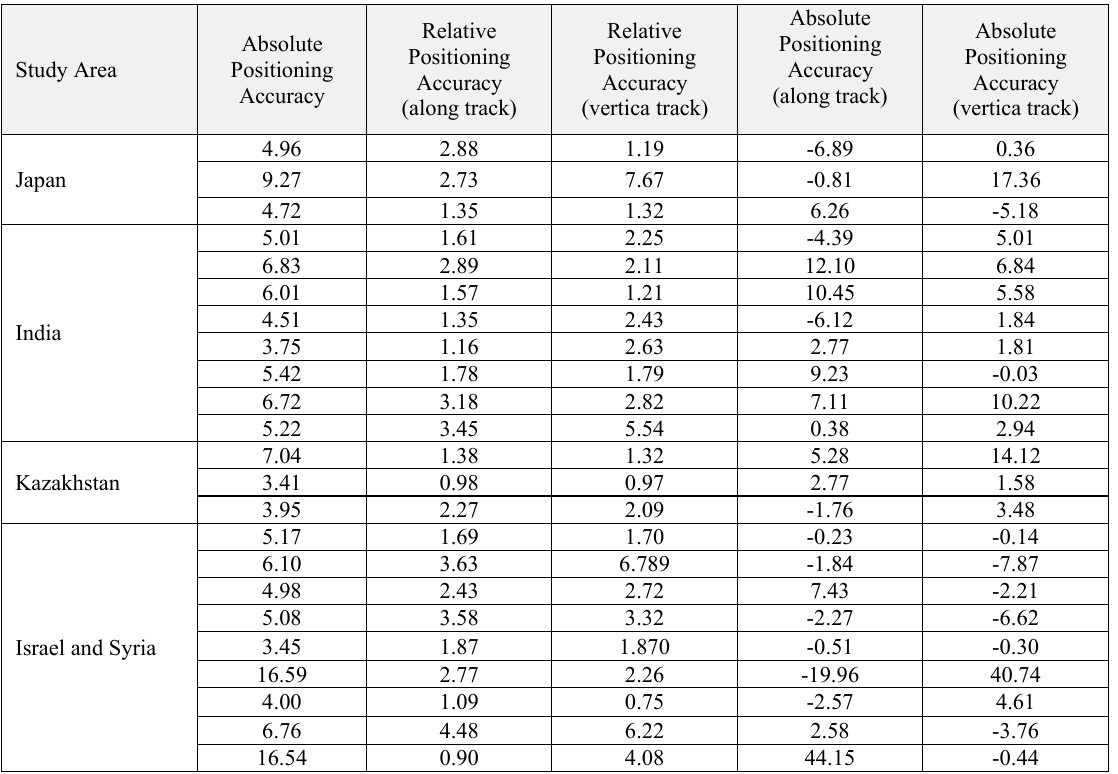
Table 1. Error statistics of the accuracy assessment over typical regions of